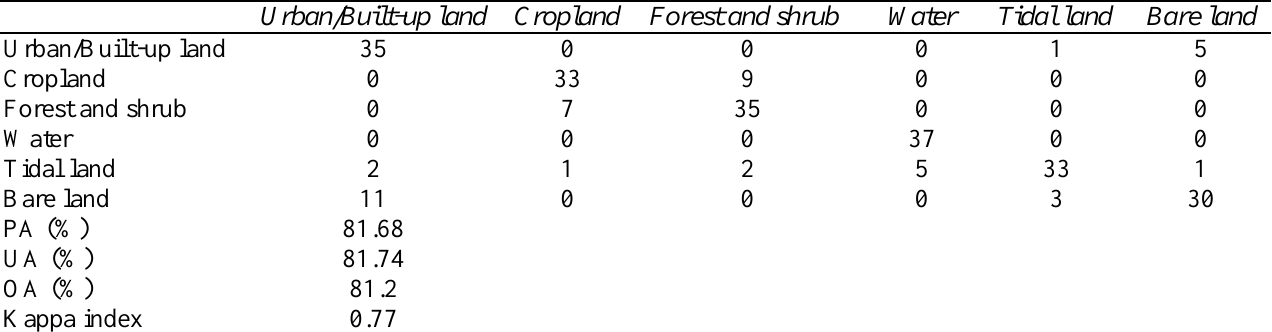
Table 4 . 2008 accuracy assessment of land use classification (Kappa index and overall